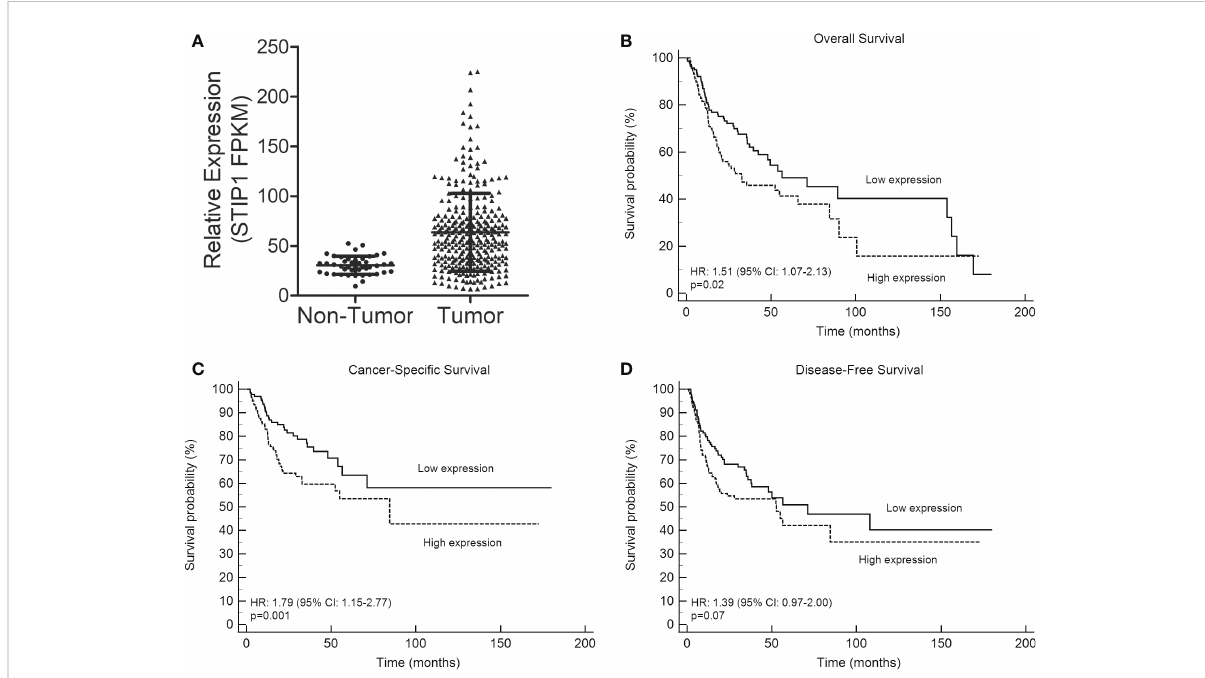
FIGURE 1 STIP1 is overexpressed in OSCC and its expression levels is associated with outcome. (A) Levels of STIP1 in OSCCs and controls (non-tumor) were compared in the RNA-Seq data from the TCGA database, revealing a signi fi cantly higher expression in OSCCs (p<0.0001). The impact of STIP1 mRNA levels on overall survival (B) , cancer-speci fi c survival (C) and disease-free survival (D) were assessed based on Kaplan-Meier curves and log-rank test using the TCGA-OSCC